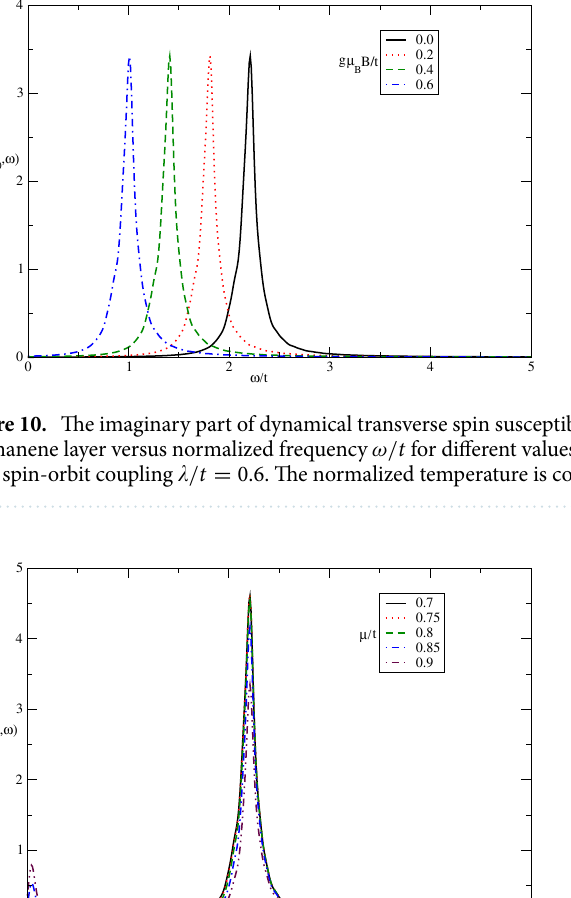
( q 0 , ω) of doped Germanene +−